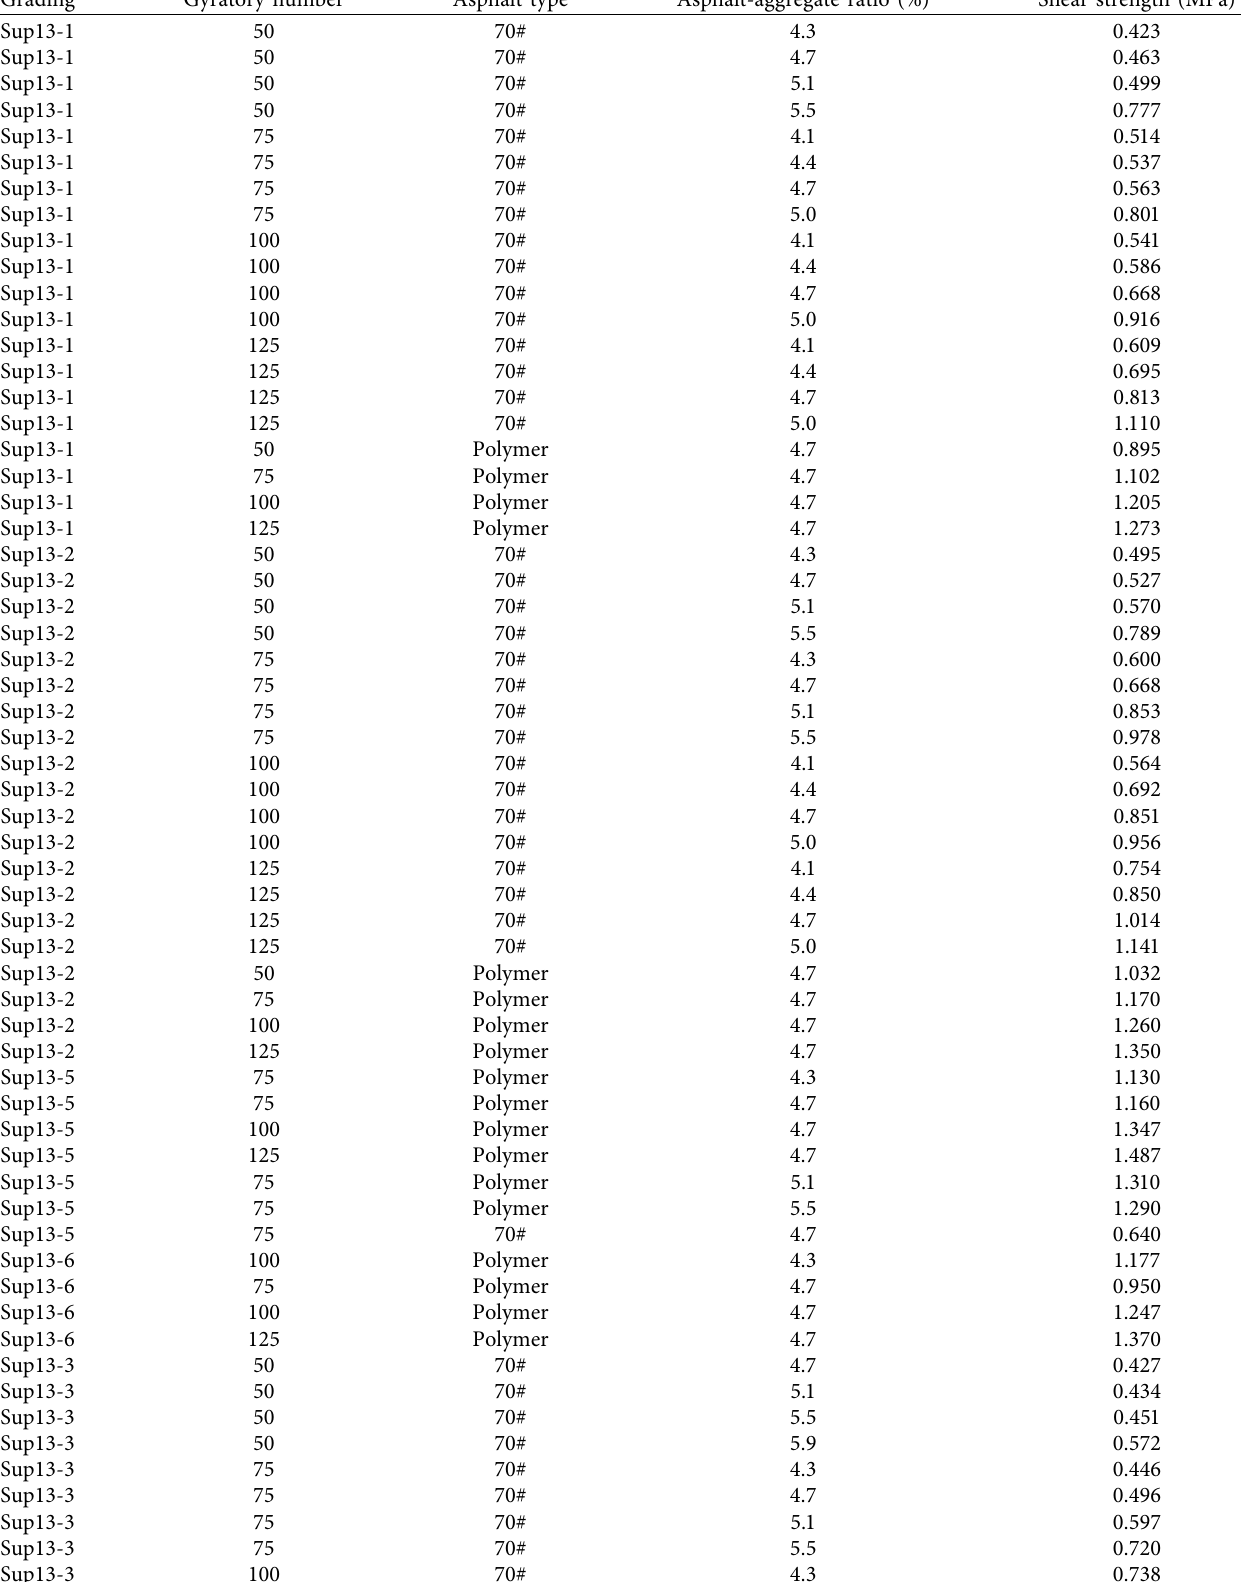
Table 4: Shear strength of 101 sets of asphalt